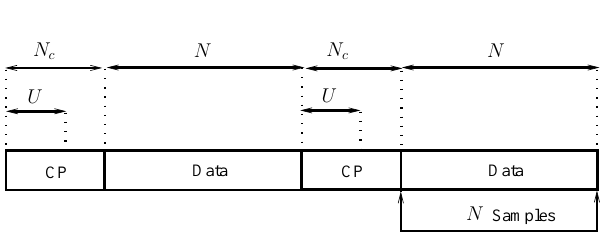
Figure 3. Illustration for the scenario of synchronous sensing.